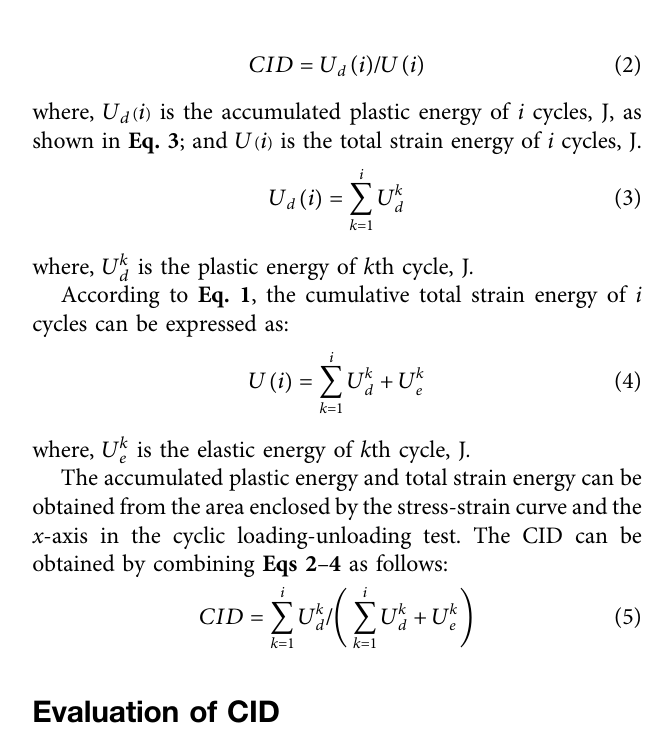
FIGURE 5 | Sketch map of strain energy of coal sample during loading and unloading (A) the 1 st loading-unloading cycle; (B) the i th loading-unloading cycle.